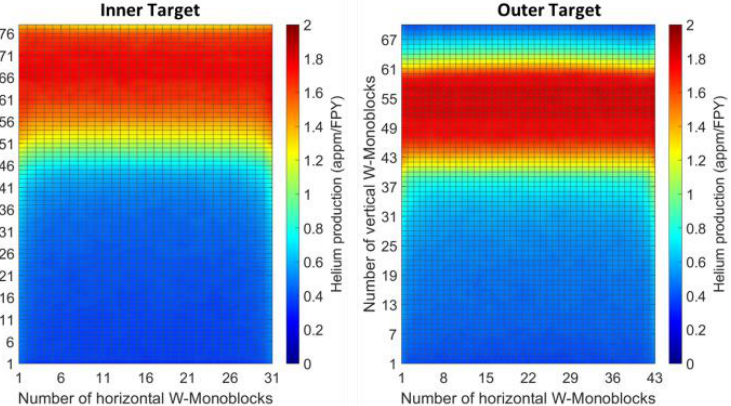
Figure 23. He-production (appm/FPY) distribution on W-monoblocks of the inner ( left ) and outer ( right ) target, with WCLL blanket.